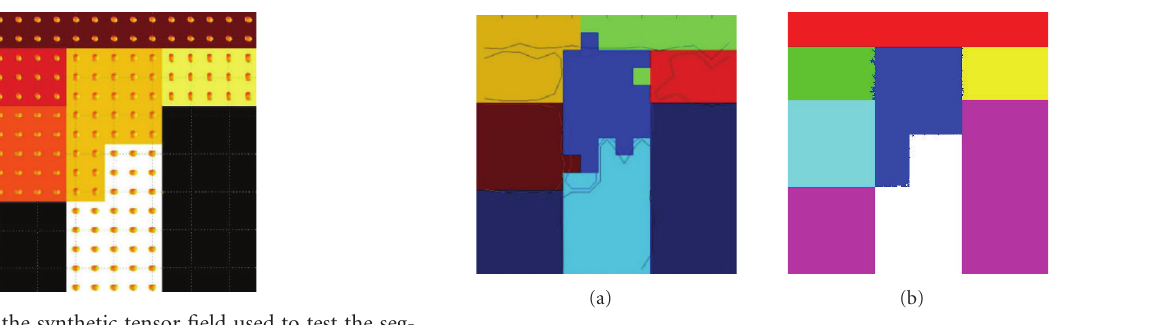
Figure 8: Segmentation results on a synthetic field, with SNR = 32. (a) Results of [4] displayed on the results obtained with the K- means algorithm. (b) Results from our